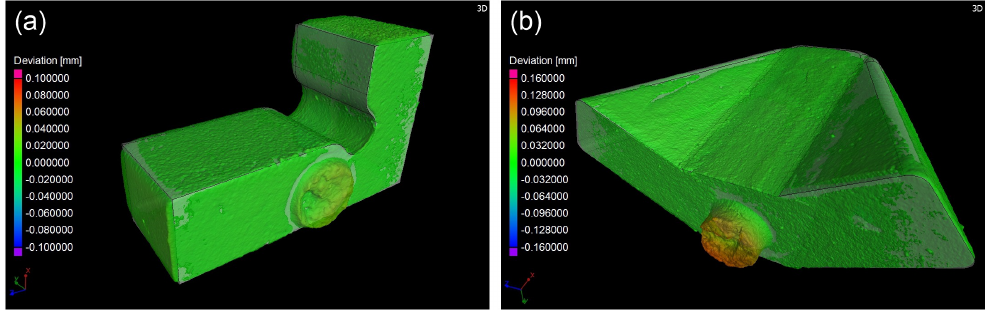
Figure 7. Nominal/actual comparison: ( a ) L-angle. ( b ) Abstract